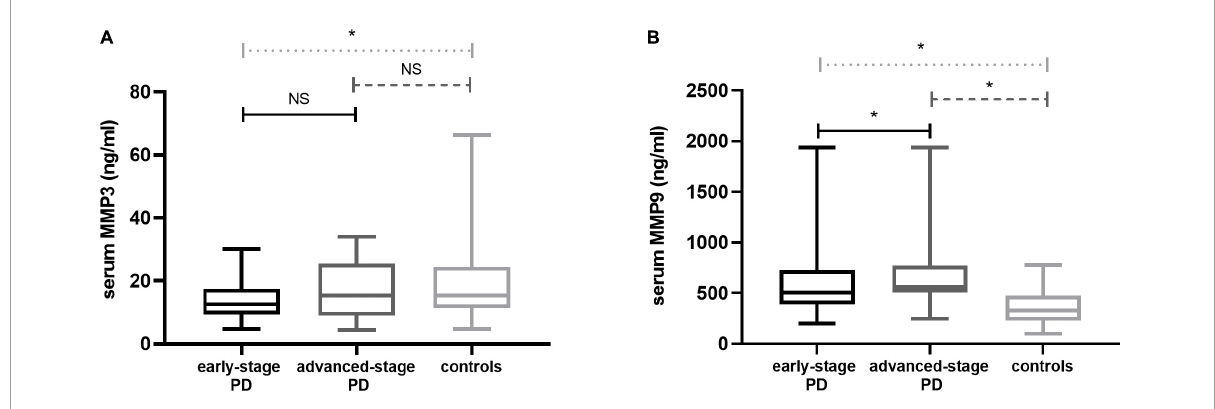
FIGURE1 Serum MMP3 and MMP9 levels in PD patients and contr subjects. (A) MMP3 levels in the PD group with early-stage disease were highly decreased in the serum compared with the controls; There was no statistically significant difference in serum MMP3 levels in patients with advanced-stage PD compared to healthy controls; Compared to PD patients with early-stage disease, MMP3 levels in advanced-stage PD patients were higher, while there were no significant differences. (B) MMP9 in the PD group with early-stage disease was increased in the serum compared with the controls; Serum levels were elevated in the advanced-stage PD group relative to the control group; Compared to PD patients with early-stage disease, MMP9 levels in advanced-stage PD patients were higher. PD, Parkinson’s disease; MMP3, Matrix Metalloproteinase 3; MMP9, Matrix Metalloproteinase 9. The central line in each box indicates the median, box edges mark the first and third quartiles, and limits of the vertical lines show ranges. NS, no significance; * P <